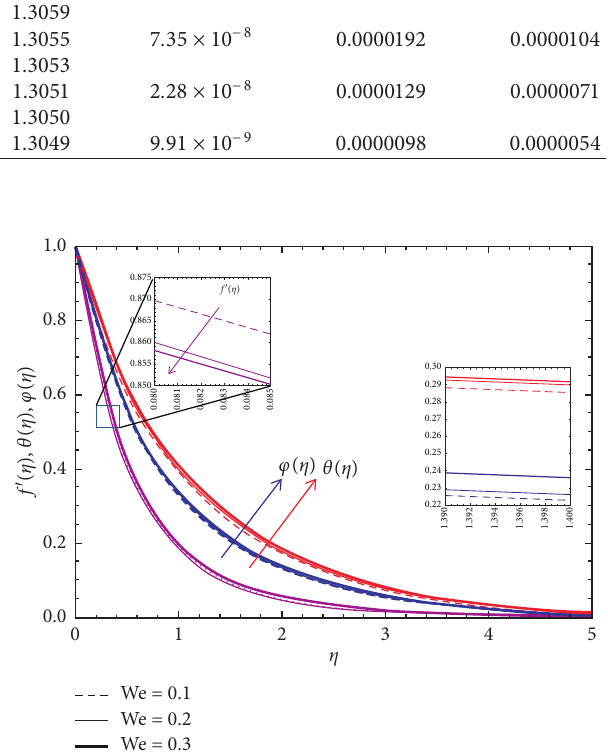
Figure 3: Impacts of unsteadiness parameter on velocity, tem- perature, and concentration profiles.